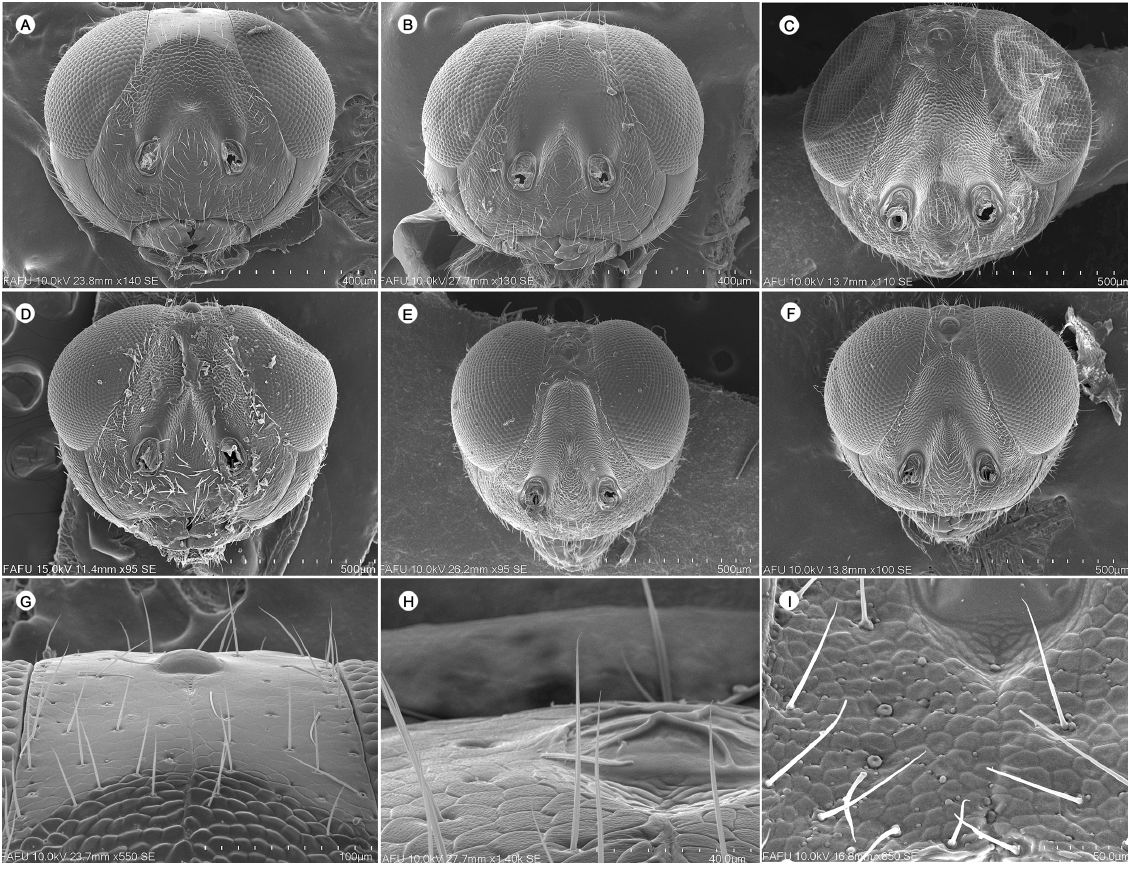
Fig. 7. SEM photos. A‒F . Head. A . Zaischnopsis covid Jiang & Peng sp. nov. B . Z . fuscolivida Tang & Peng sp. nov. C . Z . lii Jiang & Peng sp. nov. D . Z . pacis Jiang & Peng sp. nov. E . Z . campaniformis Tang & Peng sp. nov. F . Z . zhongi Jiang & Peng sp. nov. G . Z. covid , front part of frons, show sculpture and setae. H . Z. campaniformis , sculpture and setae around anterior ocellus. I . Z. lii , front part of frons, show sculpture and